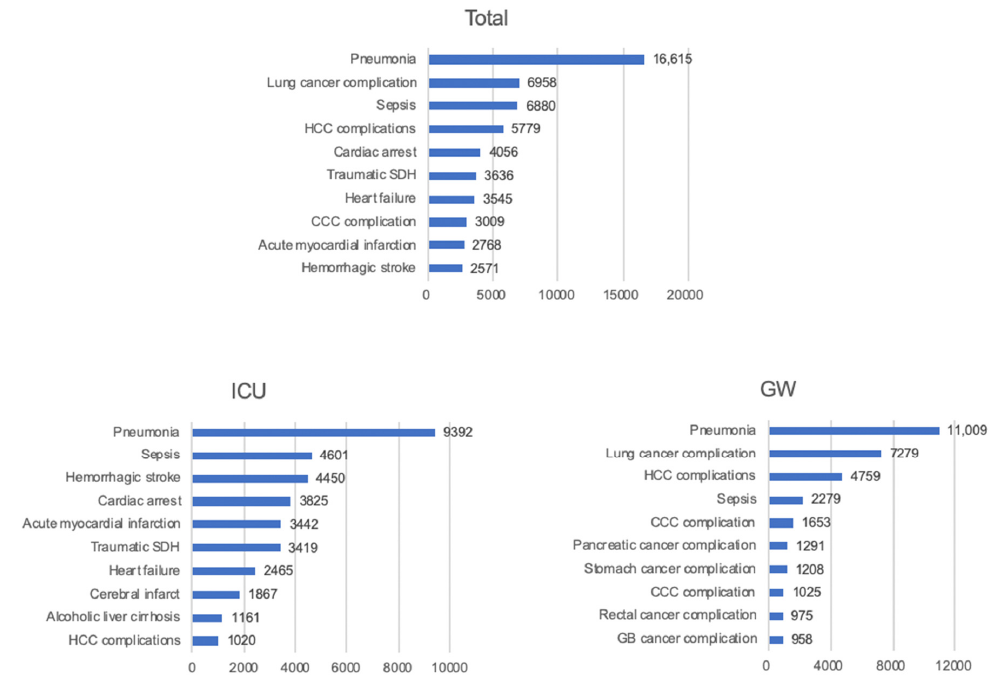
Figure 4. Top 10 diagnosed causes of death among patients admitted through the emergency department. CCC, cholangiocellular carcinoma; HCC, hepatocellular carcinoma; GB, gallbladder; GW, general ward; ICU, intensive care unit; SDH, subdural hematoma.